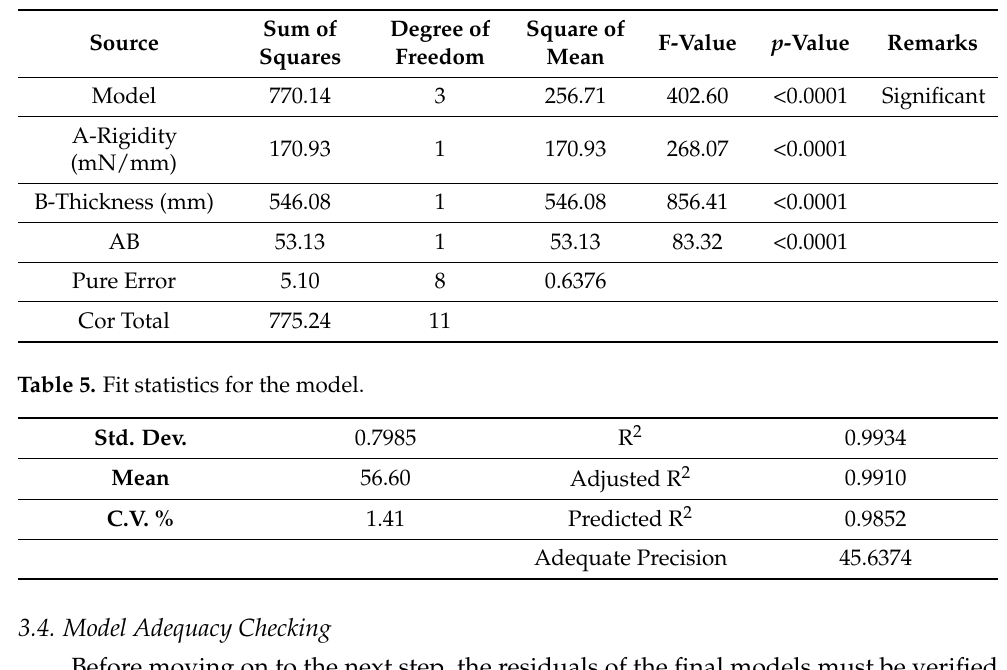
Table 4. ANOVA for the factorial model of choice.